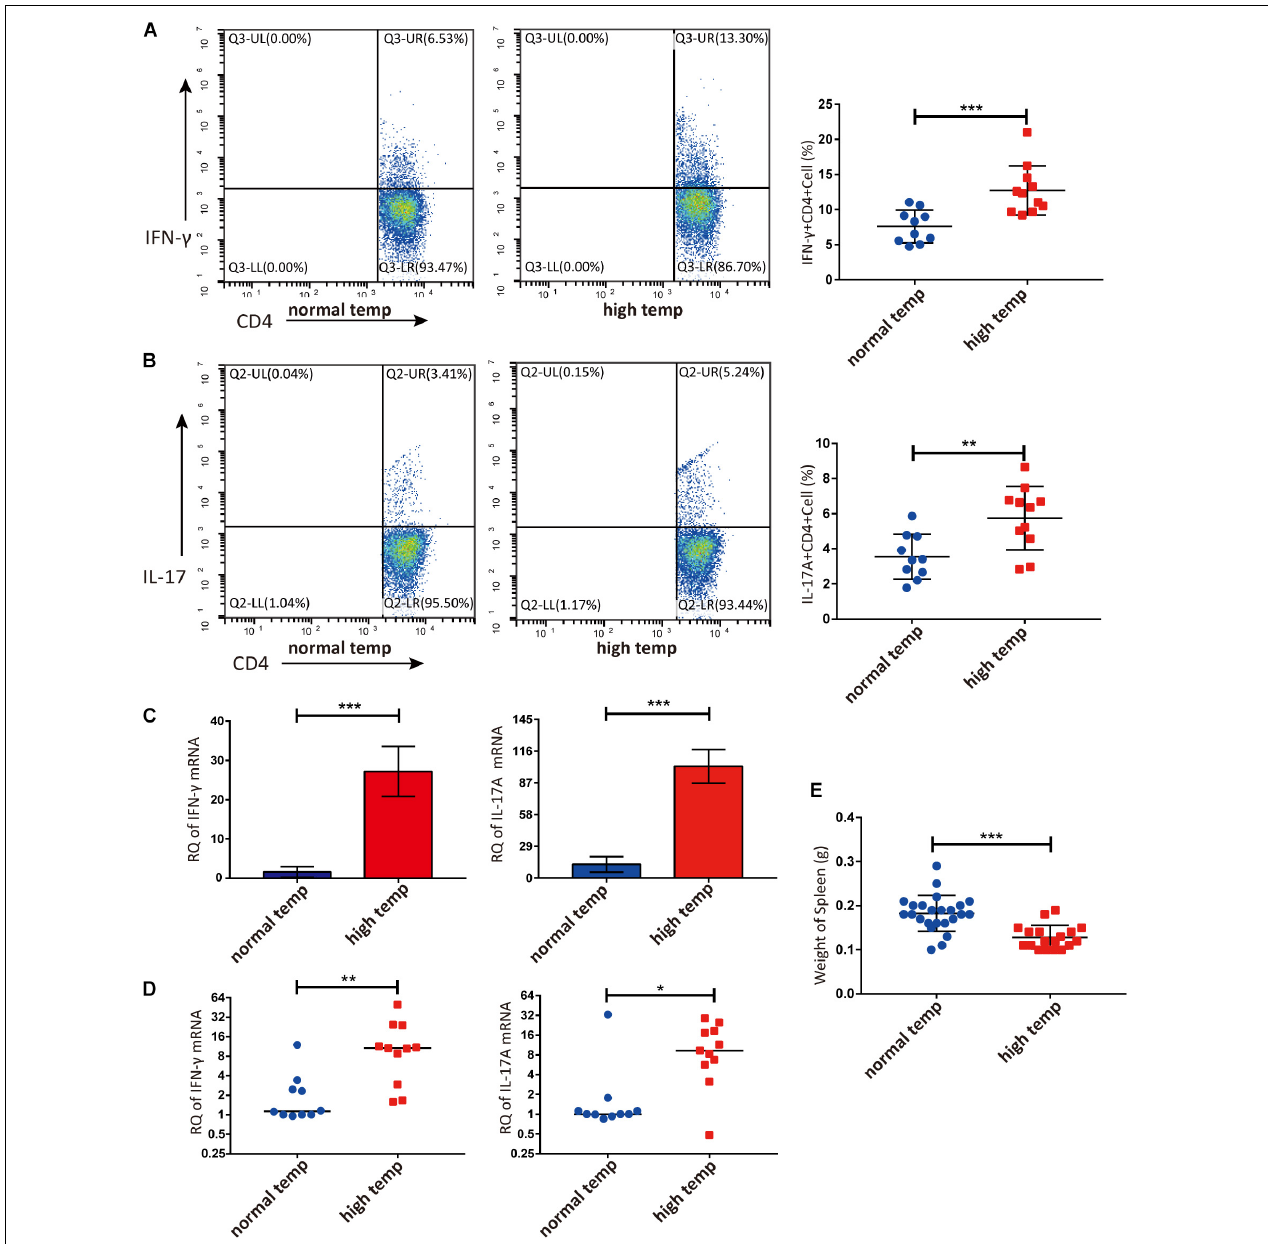
FIGURE 2 | A high temperature environment changes the frequencies of Th1 and Th17 cells in the spleen and retinas of EAU mice (day 14 after IRBP immunization). (A) Representative flow cytometry and quantification of IFN- γ +CD4 + T cells in splenic lymphocytes of EAU mice ( n normal temp = 10, n high temp = 11; mean ± SD; *** p < 0.001; Unpaired t -test). (B) Representative and quantification of IL-17A+CD4 + T cells in the splenic lymphocytes of EAU mice ( n normal temp = 10, n high temp = 11; mean ± SD; ** p < 0.01; Unpaired t -test). (C) The expression of IFN- γ , IL-17A mRNA were detected by real-time qPCR in splenic lymphocytes from EAU mice housed under normal or high temperature conditions ( n = 5/group; mean ± SD; *** p < 0.001; Unpaired t -test). (D) The expression of IFN- γ and IL-17A mRNA was detected by real-time qPCR in the retina from EAU mice ( n normal temp = 10; n high temp = 11; data were not normally distributed; median; ** p < 0.01, * p < 0.05; Differences were assessed by Mann Whitney test). (E) Weight of spleens were compared between EAU mice under high or normal temperature housing conditions ( n normal temp = 24, n high temp = 18; mean ± SD; *** p < 0.001; Differences were assessed by Unpaired t